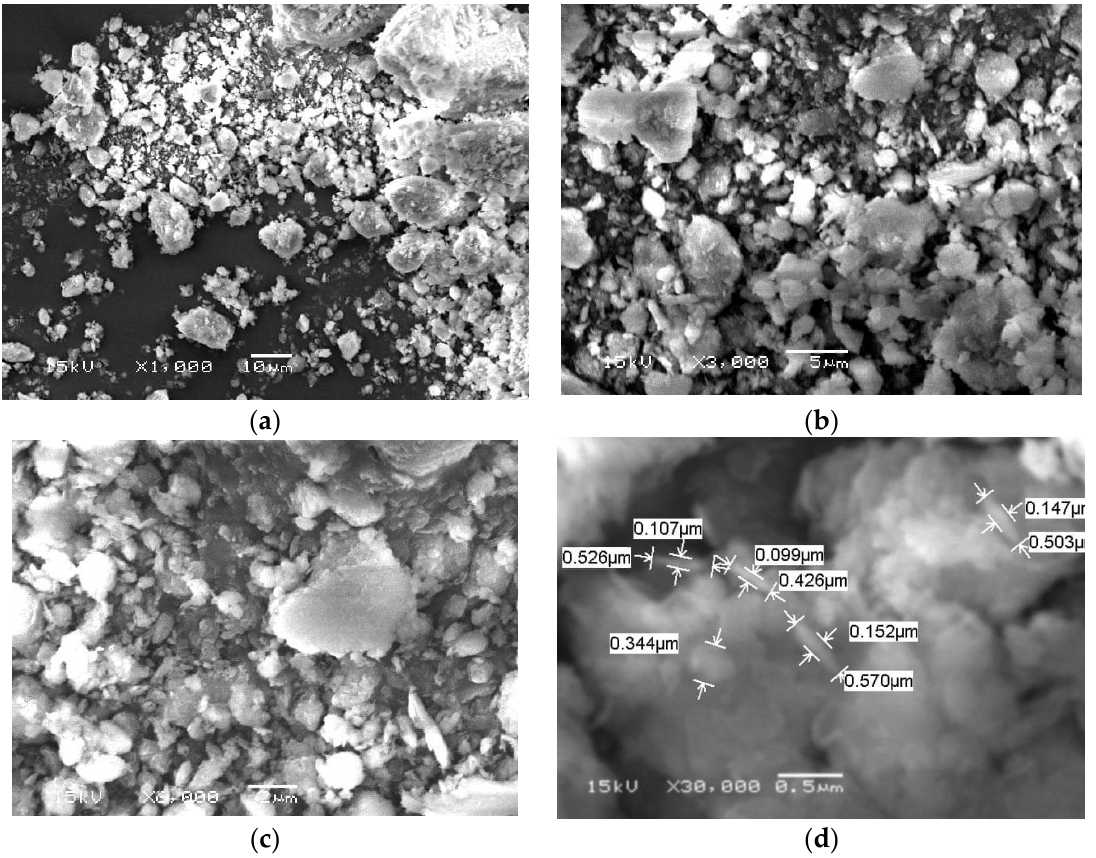
Figure 1. The surface morphology of the nano-zeolite by scanning electron microscope (SEM): ( a ) SEM with X1000; ( b ) SEM with X3000; ( c ) SEM with X6000; ( d ) SEM with X30000.